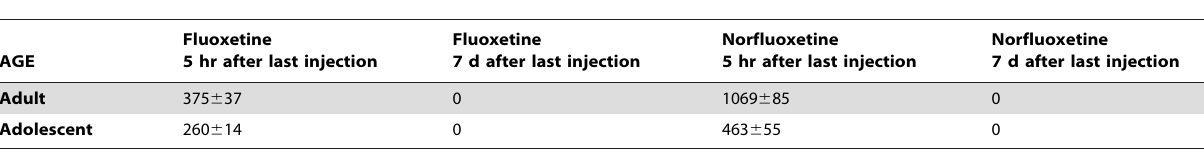
Table 2. Fluoxetine (ng/ml) and norfluoxetine (ng/ml) levels in blood plasma.